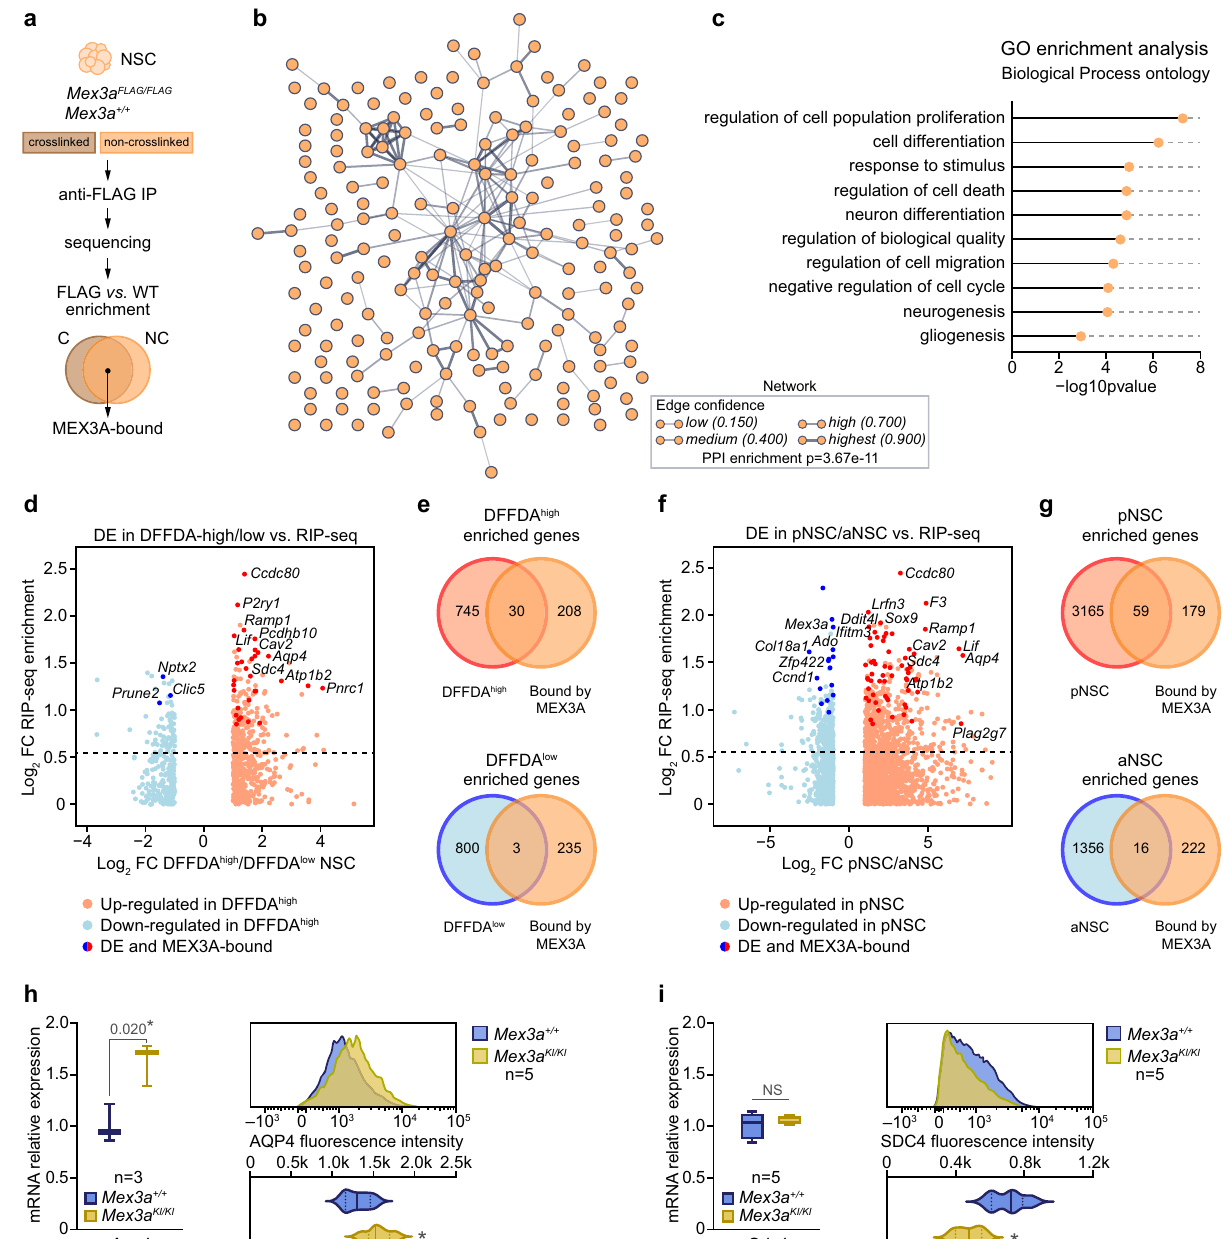
8.5×10 − 8 , by hypergeometric test). f DE data from isolated pNSC vs. aNSC populations 12 with MEX3A RIP-seq enrichment data (FDR<0.05). Red dots repre- sentup-regulated,andbluedotsdown-regulatedgenesinpNSCs.Darkredandblue dotslabelDEgenesalsoboundbyMEX3A. g OverlapbetweenMEX3A-boundgenes (orange) and genes enriched in pNSCs (red, top) and aNSCs (blue, bottom). pNSC and MEX3A-bound genes show more overlap than expected ( p -value=0.003, by hypergeometric test). Quanti fi cation of Aqp4 ( h ) and Sdc4 ( i ) gene expression by RT-qPCRin Mex3a +/+ and Mex3a KI/KI NSCs(leftpanels)( * p -value<0.05andNS=0.317 by unpaired two-tailed Student ’ s t -test). AQP4 ( h ) and SDC4 ( i ) protein levels (median fl uorescence intensity) by FACS in wild-type and KI homozygous NSC cultures (right panels) (p-values: AQP4=0.032, SDC4=0.011, by unpaired two- tailed Student ’ s t -test). Box plots show median± interquartile range and whiskers de fi ne minimum to maximum. Exact p -values and the number of biologically independent samples used are indicated. Source data are provided as a Source Data fi